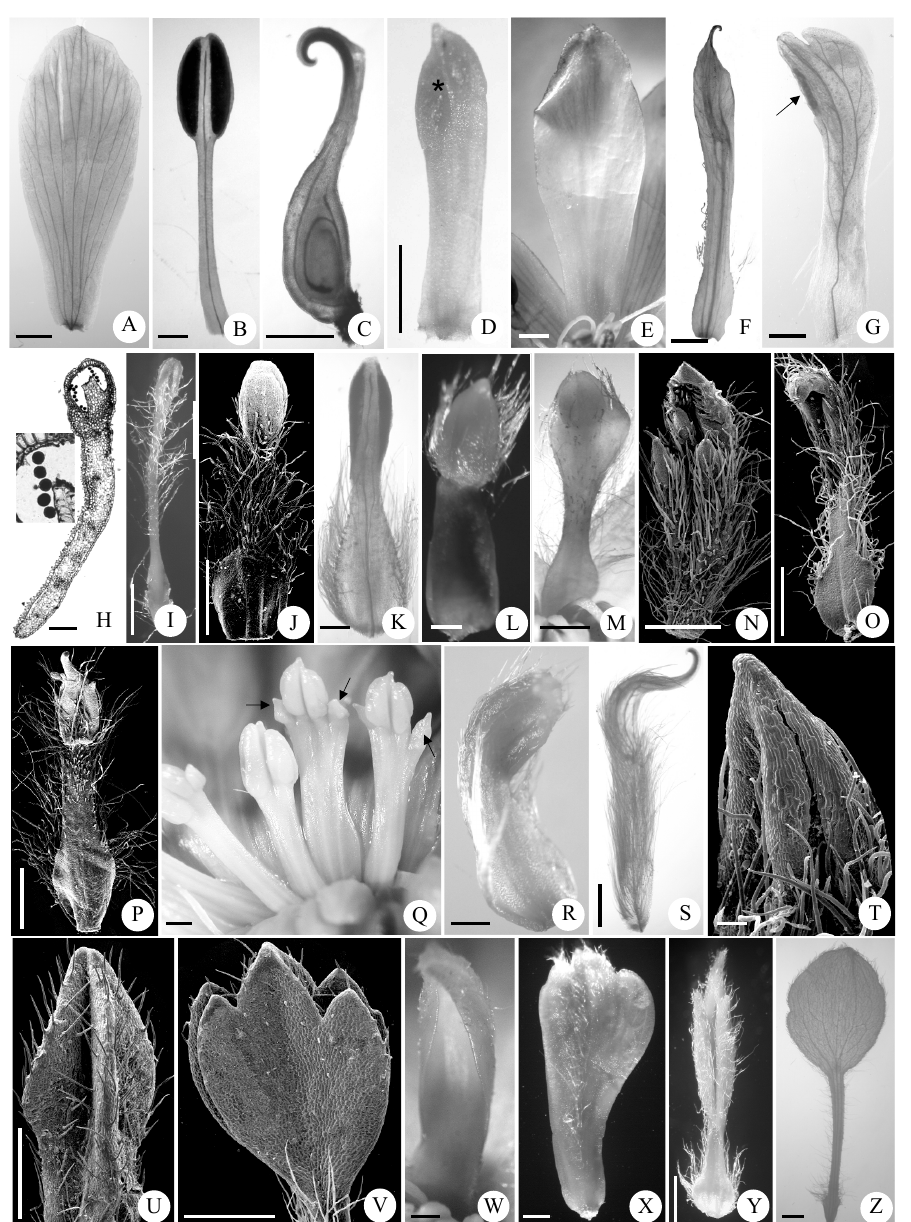
Figure 3. Normal and metamorphic floral organs of Anemone barbulata . ( A ) Normal sepal. ( B ) Normal stamen. ( C ) Normal carpel. ( D ) A metamorphosed stamen of white sepaloid structure containing a residual anther on the top (black star). ( E ) The metamorphosed stamen of a white sepaloid structure morphologically similar to the normal sepal. ( F ) The metamorphosed stamen of sepaloid structure showing the hooked tip and the basal three veins. ( G ) The white sepaloid structure containing a residual pollen sac on one side (arrow). ( H ) Histological observation of the cross-section of the sepaloid structure displayed in ( G ) showing the pollen sac and pollen grains. ( I – Q ) Various types of structural stamens. ( I ) A slightly metamorphic structural stamen. ( J ) A highly metamorphic structural stamen with a basal sheath. ( K ) A metamorphic structural stamen with the enlarged base and a sharp tip. ( L ) A metamorphic structural stamen containing the long trichomes between the filament and anther. ( M ) A metamorphic structural stamen containing a residual anther at the tip. ( N ) A 3-lobed curled metamorphic structural stamen. ( O ) A metamorphic structural stamen with adaxially concave top portion. ( P ) A metamorphic structural stamen with a 3-pointed bump at the tip. ( Q ) A metamorphic structural stamen with pointed bumps (black arrows) at the base of the